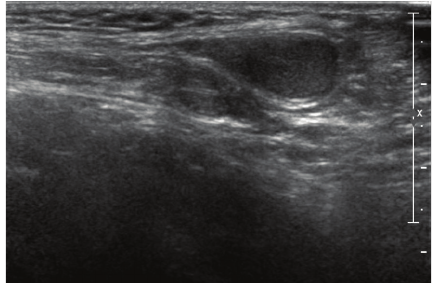
Figure 1: Left epididymis and testis with no pathological signs seen in scrotal ultrasonography.